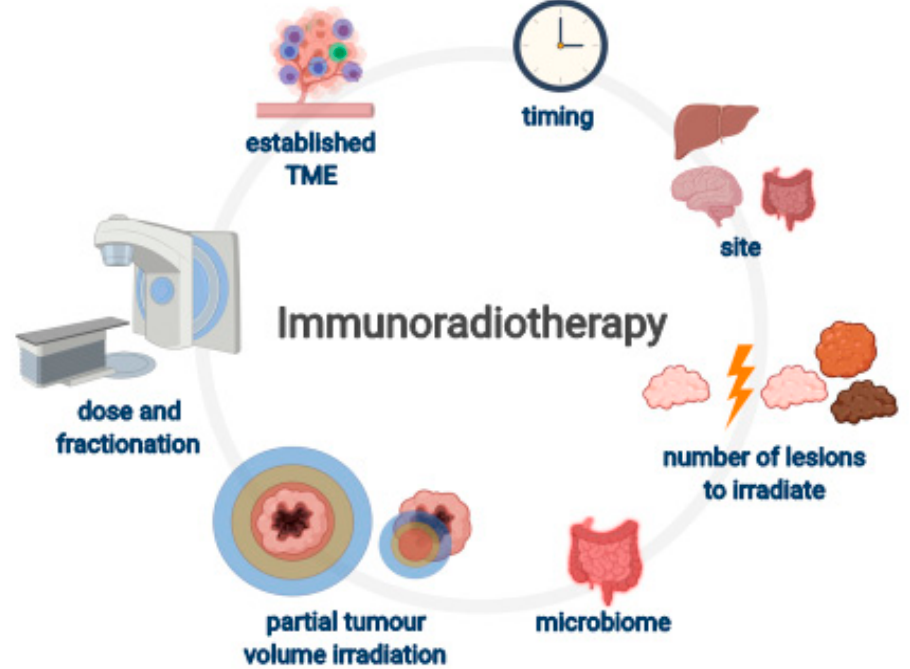
Figure 3. Factors to consider in trials of combined radiotherapy (RT) and immunotherapy. Even though the most e ff ective RT dose-fractionation in the setting of immunoradiotherapy is still ill-defined, biological rationales for particular RT schemes are being elucidated. Due to inherent radiosensitivity of lymphocytes and di ff erent mechanisms of actions of immunotherapeutics, temporal coordination of RT and immunotherapy is most important. Reducing overall tumor burden and interlesional heterogeneity point in favor of multisite irradiation vs. single-site irradiation in metastatic setting. It also seems irradiation of lesions in di ff erent organs, e.g., in liver vs. in brain, leads to di ff erent immunogenic results. Importantly, partial tumor volume irradiation appears to confer compelling results. The characteristics of the existent immunosuppressive tumor microenvironment (TME) are heterogeneous and dynamic and present a key obstacle to (radio) immunotherapy e ffi cacy. (Created with BioRender.com).